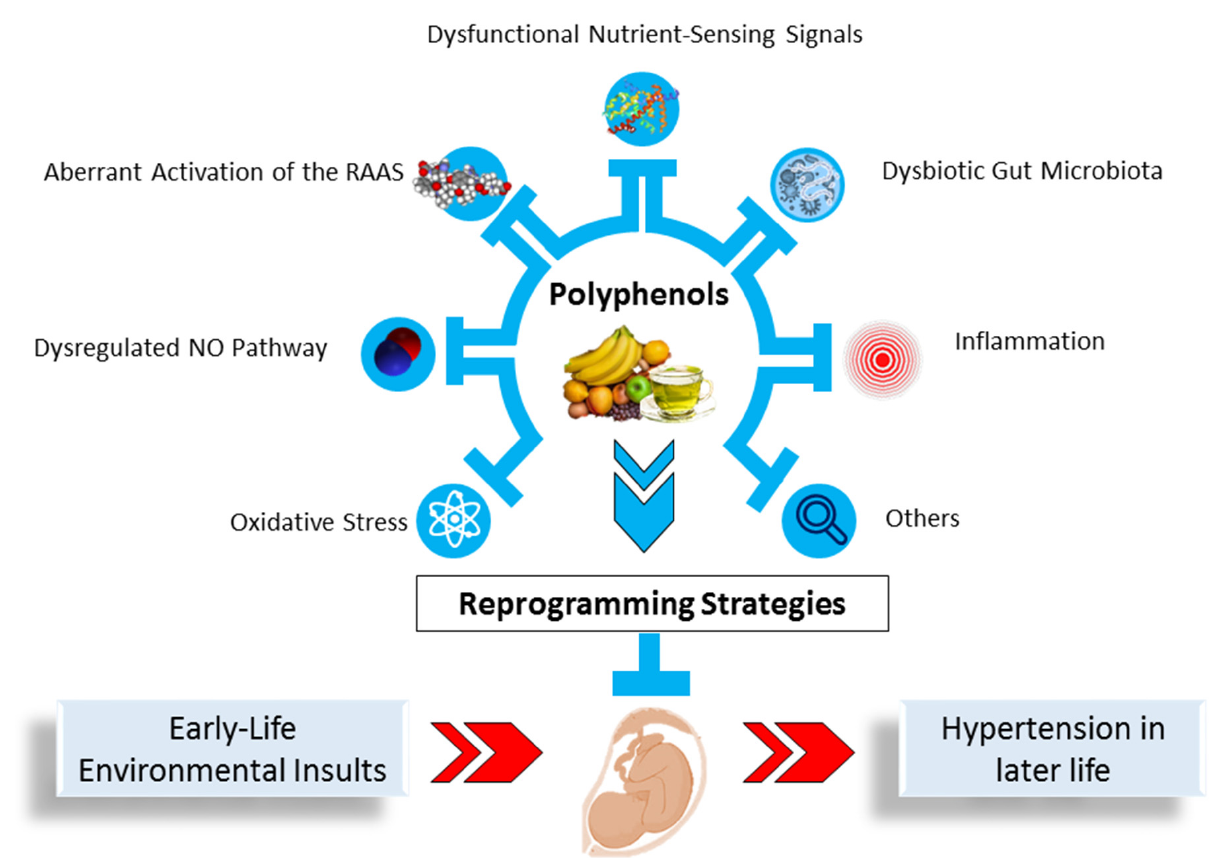
Figure 3. Schema outlining protective role of polyphenols as a reprogramming strategy for mediating common mechanisms behind early-life origins of hypertension programmed by environmental insults. NO, nitric oxide; RAAS, renin–angiotensin–aldosterone system.